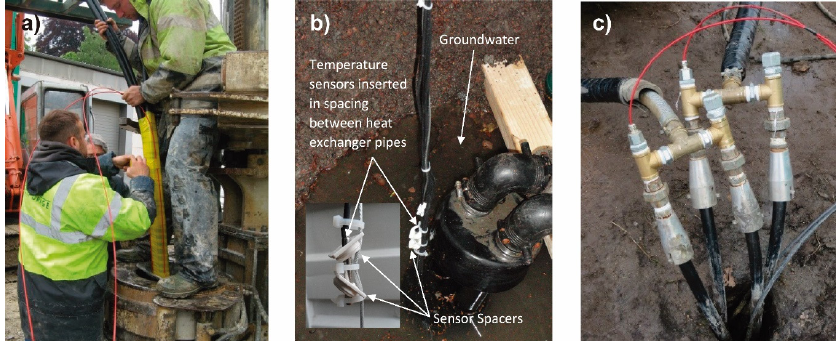
Figure 13. Construction details for distributed thermal response tests ( a , b ) Installation of temperature sensors at the outer surface of U-pipes; ( c ) Fiber optic cables fitted inside the heat exchangers after borehole execution (Limelette, Belgium).